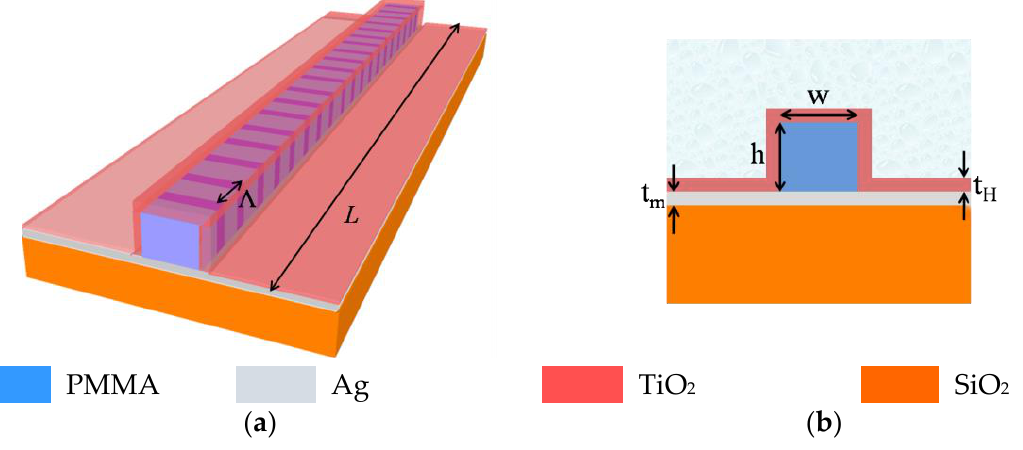
Figure 1. ( a ) 3D schematic and ( b ) cross sectional view of the proposed sensor. The Bragg grating is considered to be written in the PMMA core as a periodic mod- ulation of the refractive index having periodicity Λ and length L . Taking advantage of PMMA’s photosensitivity to UV radiation, the Bragg grating can be formed using periodic exposure to a UV laser [34,35]. It is worth noting that the reflection by the Ag layer at two sides of the waveguide core can be a source of concern while writing the grating. Therefore, a properly designed mask can be used on top of the waveguide core to expose only the PMMA core of the waveguide to the UV laser [34]. The analyte itself acts as upper cladding of the sensor